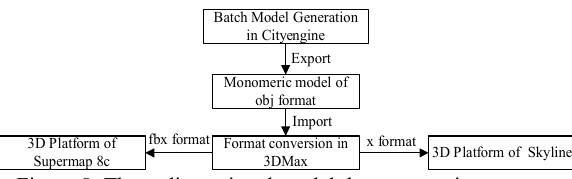
Figure 8. Three-dimensional model data conversion process